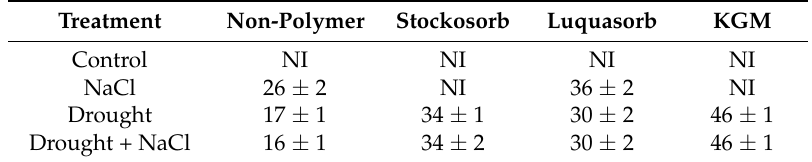
Table 1. Effect of drought and saline stress on the timing (in days) of leaf injuries in Metasequoia glyptostroboides Hu and W.C.Cheng amended with synthetic (Stockosorb, Luquasorb) or natural